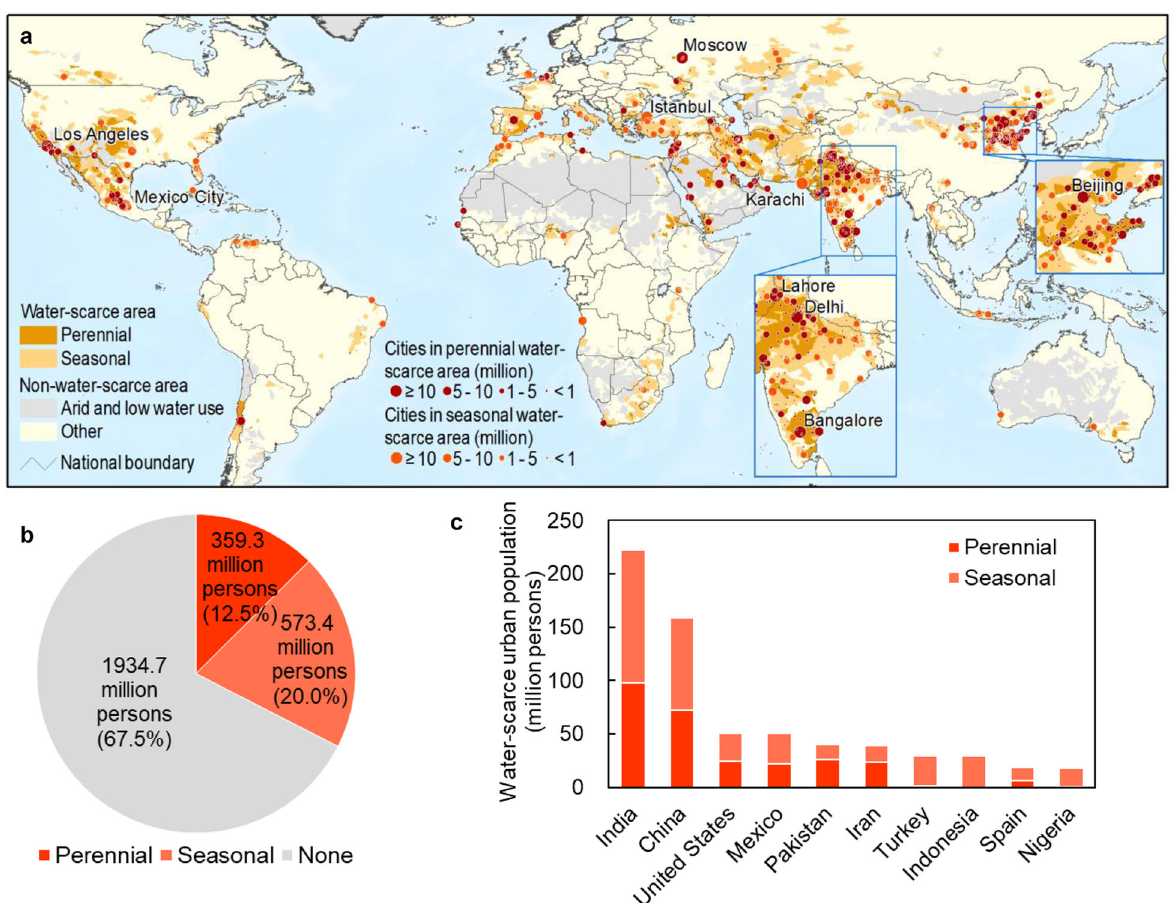
Fig. 1 Current urban water scarcity. a spatial patterns of large cities in water-scarce areas (cities with population above 10 million in 2016 were labeled). b Water-scarce urban population at the global scale. c Water-scarce urban population at the national scale (10 countries with the largest values were listed). Please refer to Supplementary Data for urban water scarcity in each